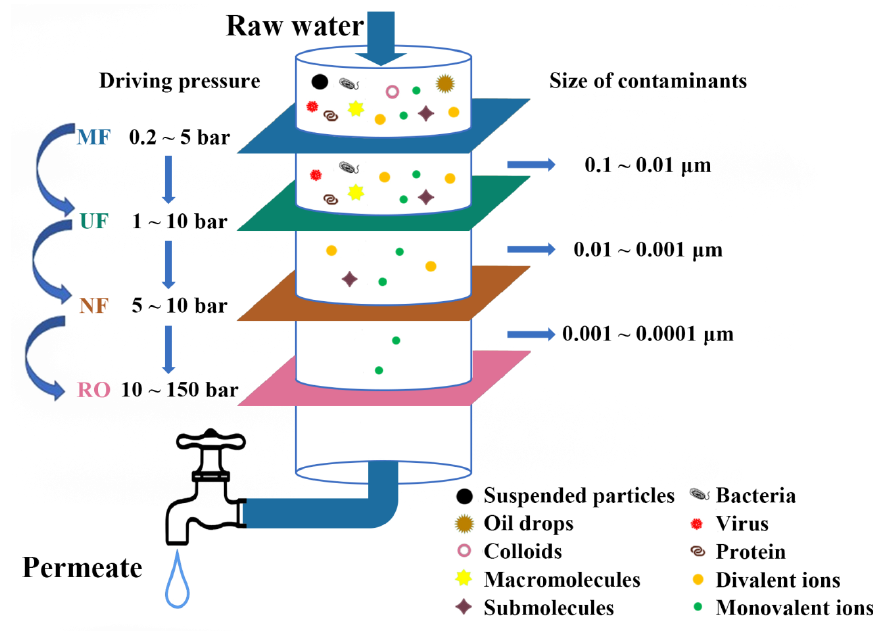
Figure 2. Schematics of a water treatment system based on pressure-driven membranes.